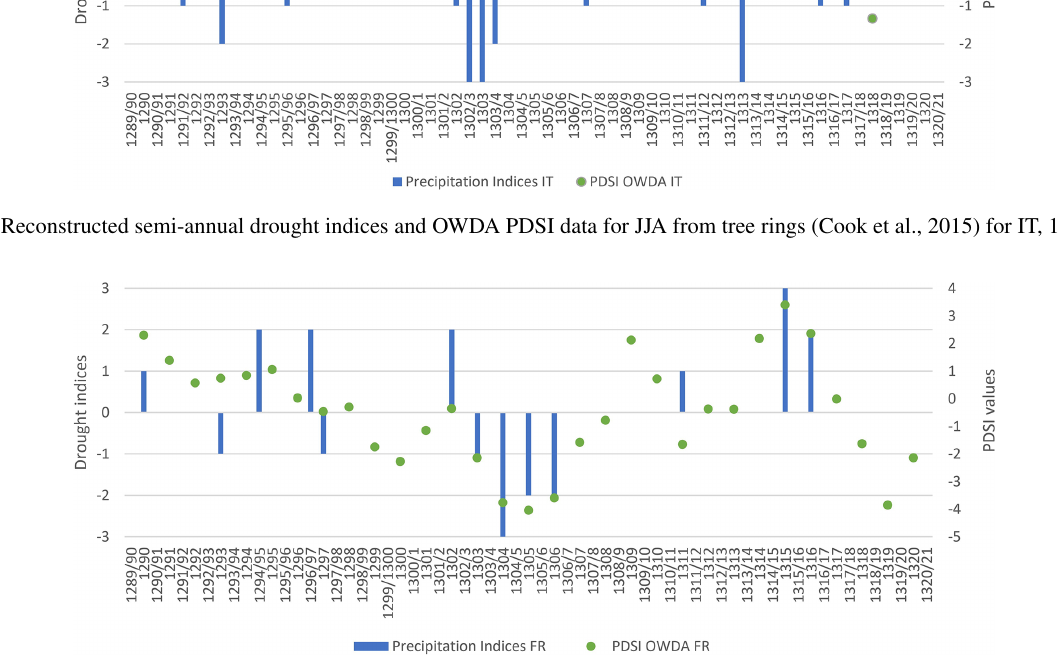
Figure 3. Reconstructed semi-annual drought indices and OWDA PDSI data for JJA from tree rings (Cook et al., 2015) for FR,